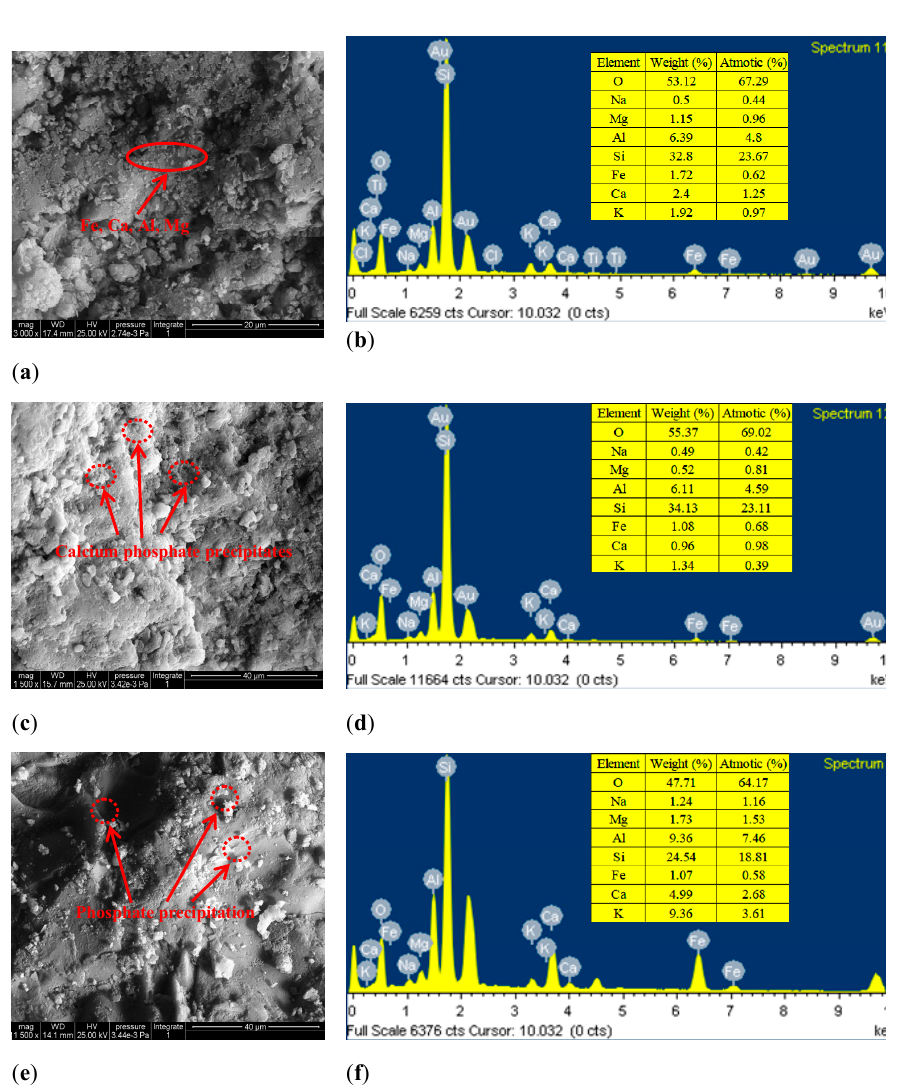
Figure 13. The figure shows the SEM images for ( a ) the zeolite before tests; ( b ) the zeolite after tests; ( c ) the post-experiment sponge iron; and, ( d ) the post-experiment limestone. The EDS spectrum is also illustrated for the following samples: ( e ) pre-experiment zeolite; ( f ) post-experiment zeolite; ( g ) post-experiment sponge iron; and, ( h ) post-experiment